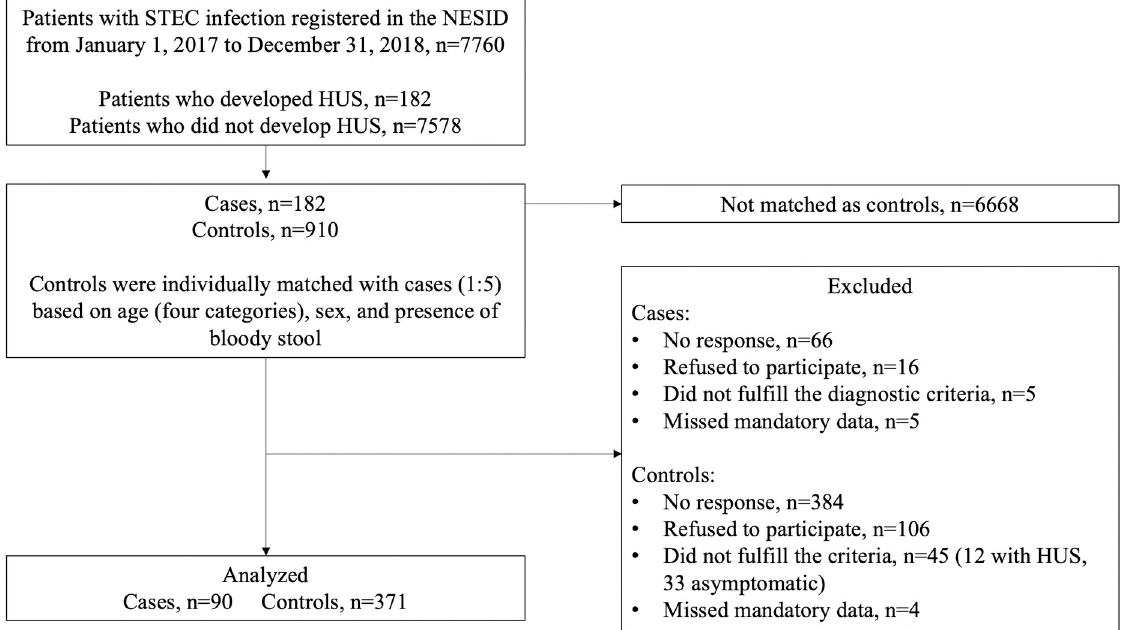
Fig 1. Study flow chart. HUS, hemolytic uremic syndrome; NESID, National Epidemiological Surveillance of Infectious Diseases; STEC, Shiga toxin-producing Escherichia coli .